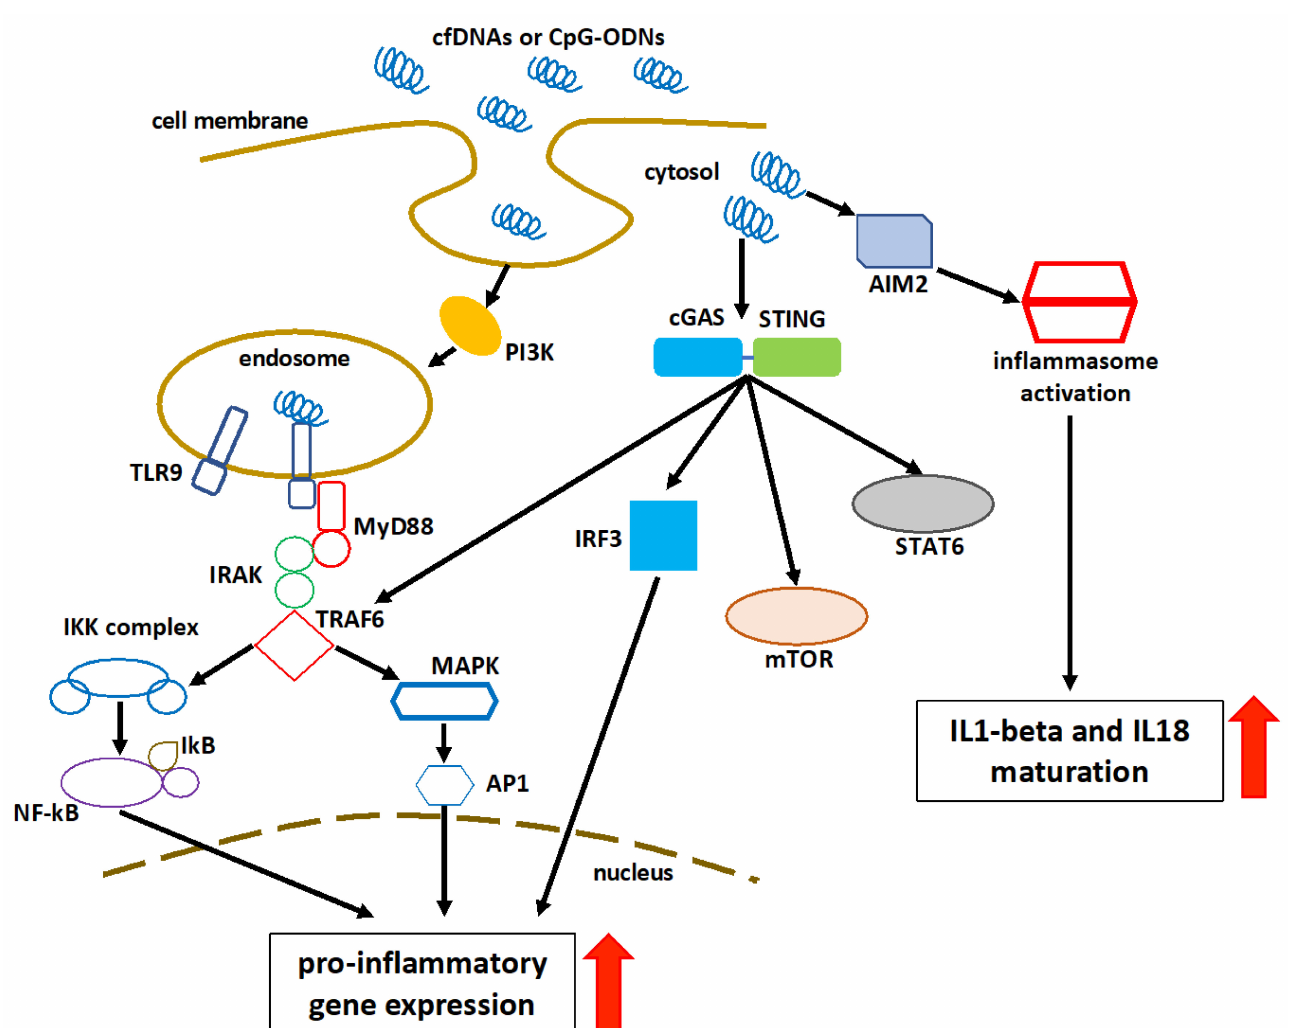
Figure 2. Schematic representation of cell-free DNA sensing and consequent pathway activation. Class III PI3K promotes the internalization of cfDNA and CpG-ODNs into TLR9-containing endoso- mal vesicles. The intracytoplasmic activation signal is transmitted via the interaction of cfDNA and TLR9. MyD88 is recruited to the Toll–interleukin-1 receptor domain of TLR9, followed by the activa- tion of the IRAK–TRAF6 complex. This activates both the MAPK and the inhibitor of IKK complexes, resulting in the overexpression of transcription factors, such as NF-kB and AP1. cGAS-mediated detection of cytosolic DNA initiates a STING-dependent reaction. The cGAS-STING pathway can also activate IRFs, mTOR, STAT6, and MAPK in a direct or indirect way. In the cytosol, AIM2 binds to the double-stranded DNA, resulting in the creation of the AIM2 inflammasome. This results in the activation of caspase 1, the maturation of proinflammatory cytokines IL-1 β and IL-18, and finally pyroptosis. AP1: activator protein 1; red arrows: